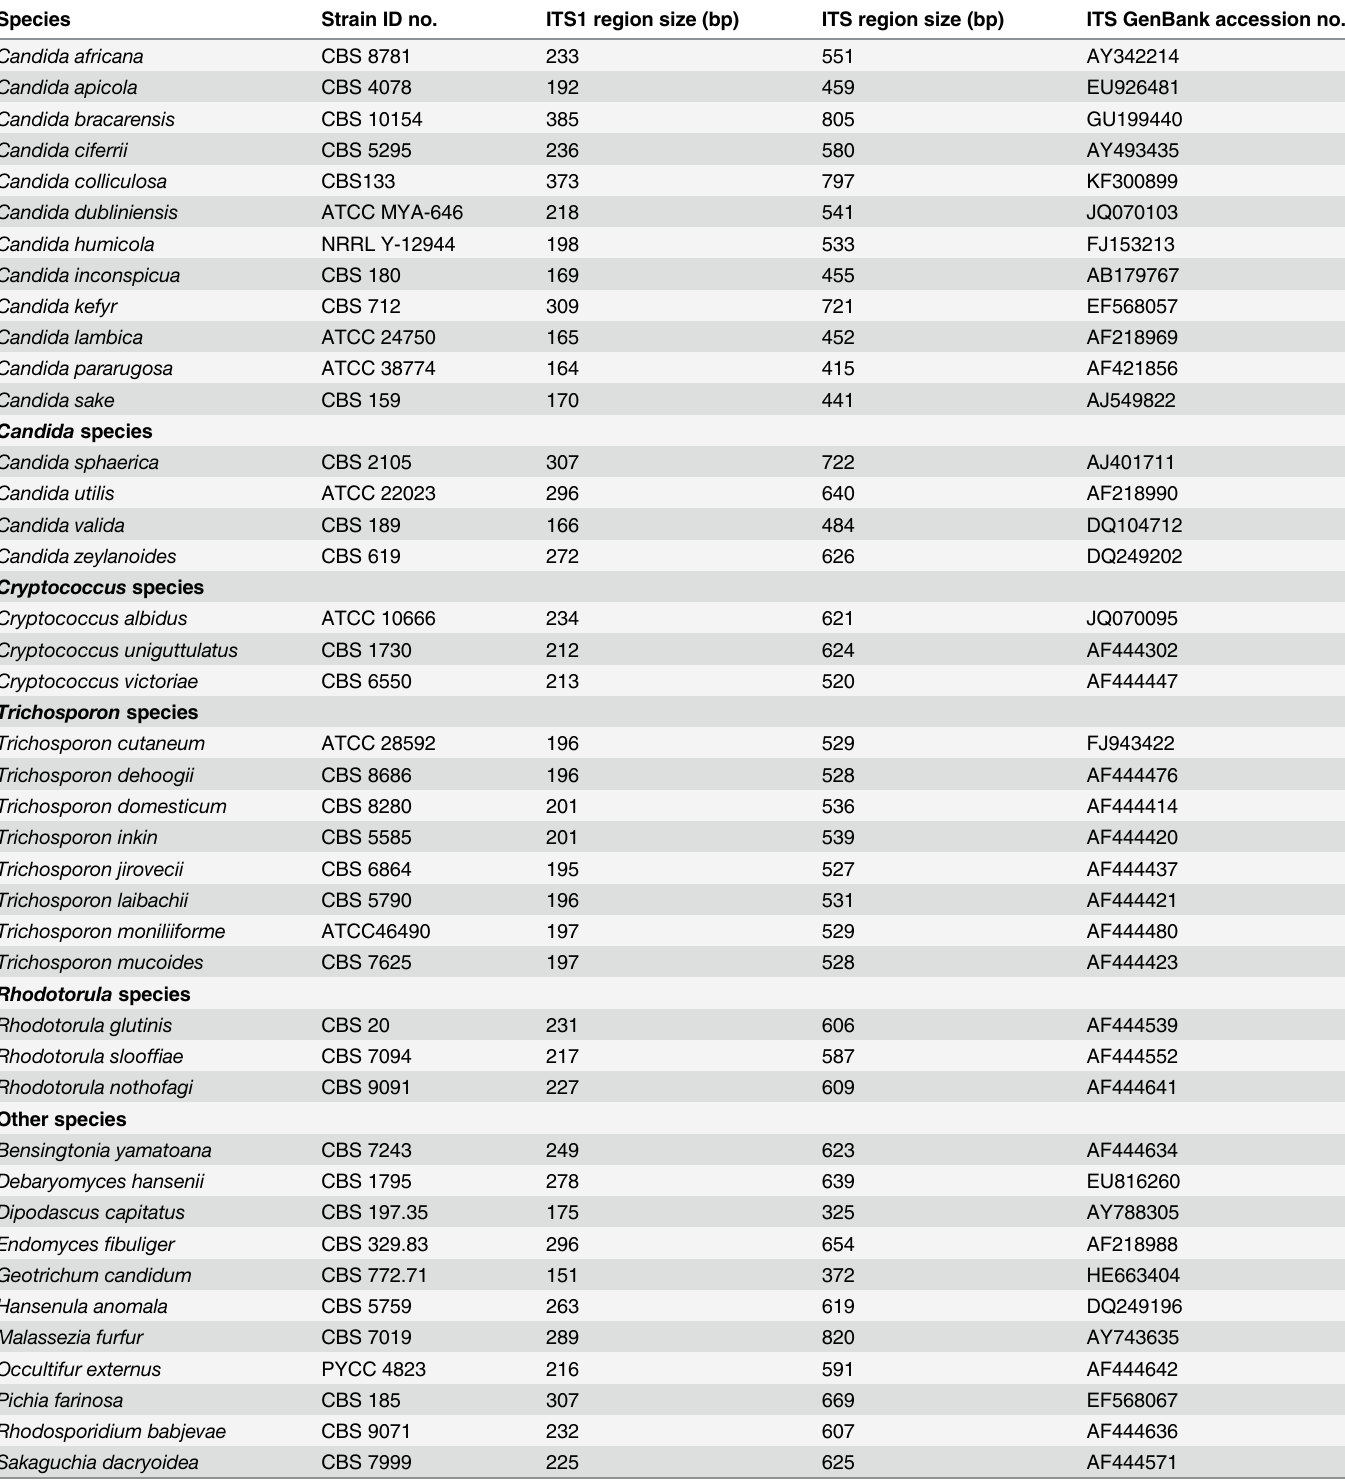
Table 3. In silico analysis of 41 yeast species from GenBank not being involve in the ITS length type (LT) database. Species Strain ID no. ITS1 region size (bp) ITS region size (bp) ITS GenBank accession